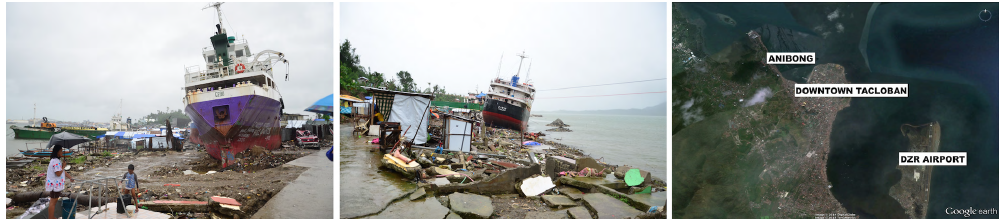
Figure 5. Stranded ships near the coast of Anibong to the north of the Tacloban downtown area. The storm surge was measured at approxi- mately 6m, and extensive damage was